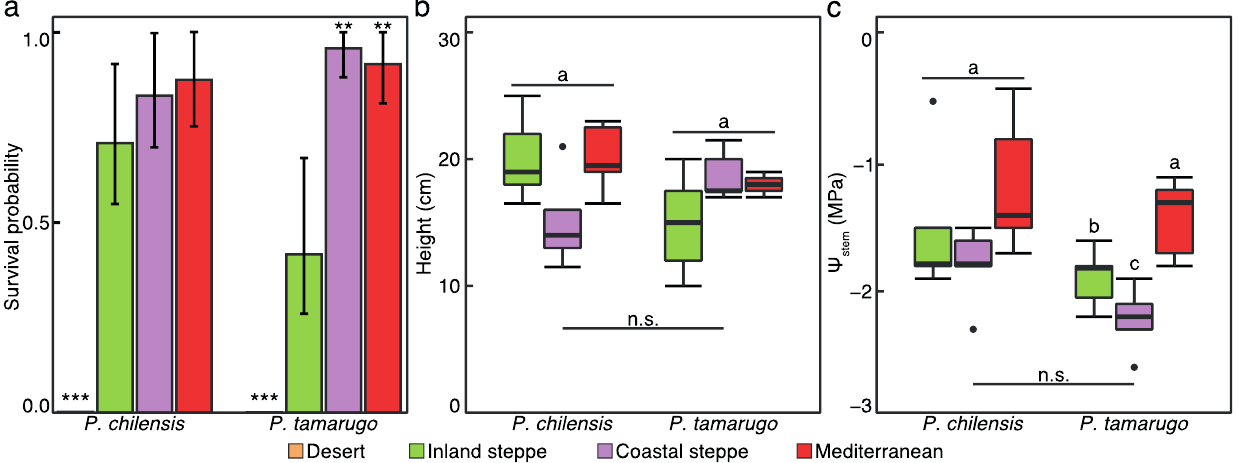
Figure 2. Bar plot of the survival probability ( a ) and boxplots of height ( b ) and stem water potential ( c ) of P. chilensis and P. tamarugo in different soils, colored by location. In ( a ) asterisks (** p < 0.01, *** p < 0.001) represent statistical differences of Cox proportional Hazard regression for n = 24. Error bars correspond to 95% confidence interval. In ( b , c ) lowercase letters in the upper part of the boxplot represent Fisher’s least significant difference (LSD) when α = 0.05 from Kruskal–Wallis testing differences between soils. Whiskers represent 1.5 × inter-quartile range (IQR). Dots correspond to outliers. Lowercase letters below the boxplots correspond to statistics from Kruskal–Wallis testing differences between Prosopis